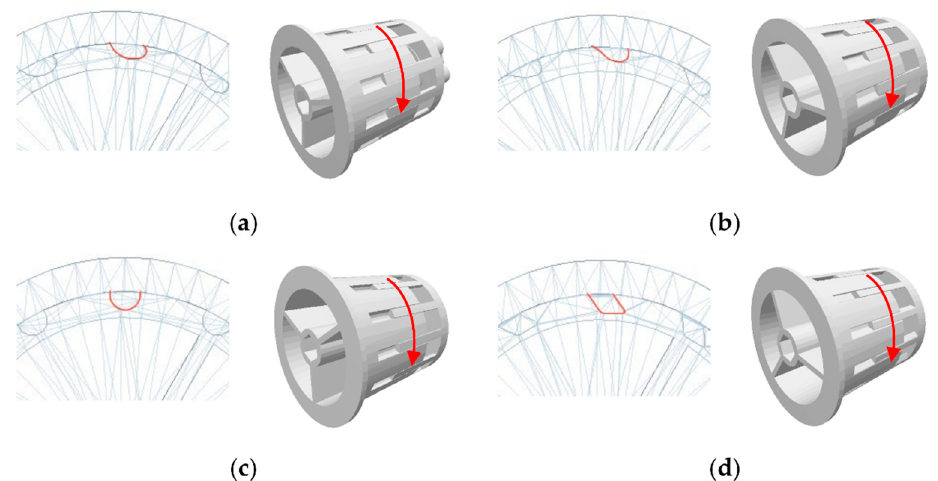
Figure 4. Four types of model-hole-wheels simulation models. ( a ) Inverted-fin-shape model-hole; ( b ) Inclined parabolic model-hole; ( c ) Bowl-shaped model-hole; ( d ) Prism-shaped model-hole; The curve of the shaped hole is represented by the red arrow.